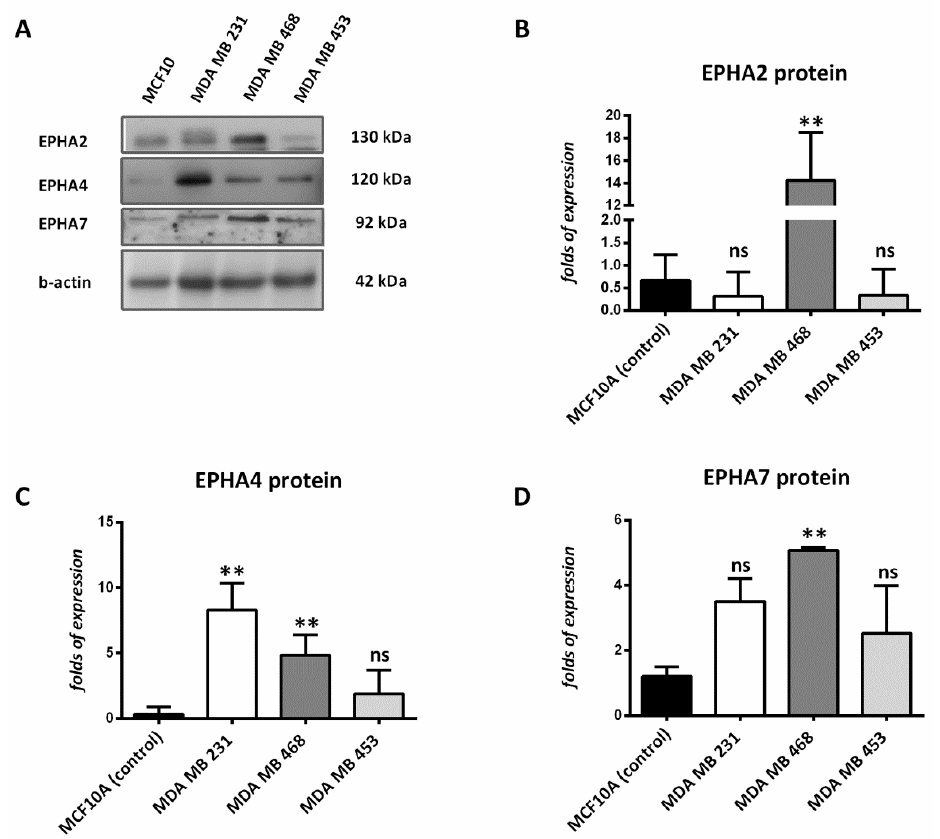
Figure 3. Protein expression analysis of EPHA2, EPHA4, and EPHA7 in MCF10A, MDA MB 231, MDA MB 468, and MDA MB 453 cell lines. ( A ) Western blot analysis of EPHA2, EPHA4, and EPHA7 protein expression in MCF10A, MDA MB 231, MDA MB 468, and MDA MB 453 cell lines. ( B ) Quan- tification of EPHA2 blots for MCF10A, MDA MB 231, MDA MB 468, and MDA MB 453 cell lines. Beta-actin was used as protein loading control. Data represent the mean and standard deviation from three independent experiments. ( C ) Quantification of EPHA4 blots for MCF10A, MDA MB 231, MDA MB 468, and MDA MB 453 cell lines. Beta-actin was used as protein loading control. Data represent the mean and standard deviation from three independent experiments. ( D ) Quantification of EPHA7 blots for MCF10A, MDA MB 231, MDA MB 468, and MDA MB 453 cell lines. Beta-actin was used as protein loading control. Data represent the mean and standard deviation from three independent experiments p < 0.05 and ** p < 0.01; ns indicates non-significance. 5. Discussion Besides their role in embryogenesis and tissue homeostasis, various EPH members are implicated in the processes of oncogenesis, tumor growth, progression, metastasis, and angiogenesis [15,18–20,22]. Investigation of the role of the EPH/ephrin system in breast cancer has mainly focused on the receptors EPHA2, EPHB4, and EPHB6 [15,17,18,28,42,43]. Notably, there are only a few EPHA expression studies on TNBC clin- ical tissue samples [32,33], although TNBC is accompanied by poor prognosis and lack of any targeted therapy. Establishing relevant clinical significance (correlation of various EPHs’ expression on human material with clinicopathologic characteristics and patient survival) is a fundamental step prior to the development of personalized therapies for